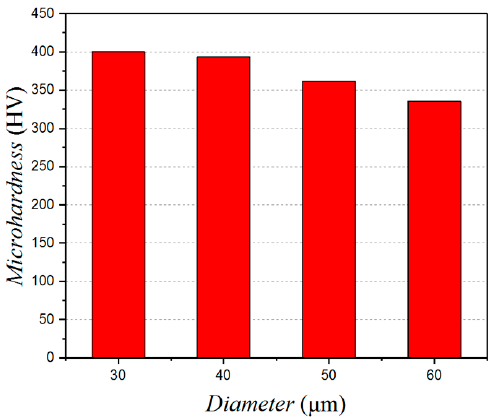
Figure 11. Influence of the micro ‐ texture diameter on the surface micro ‐ hardness.